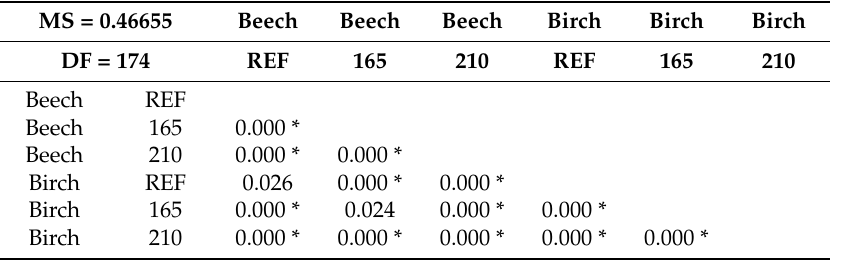
Table A9. Duncan’s Multiple Range Test for Moisture